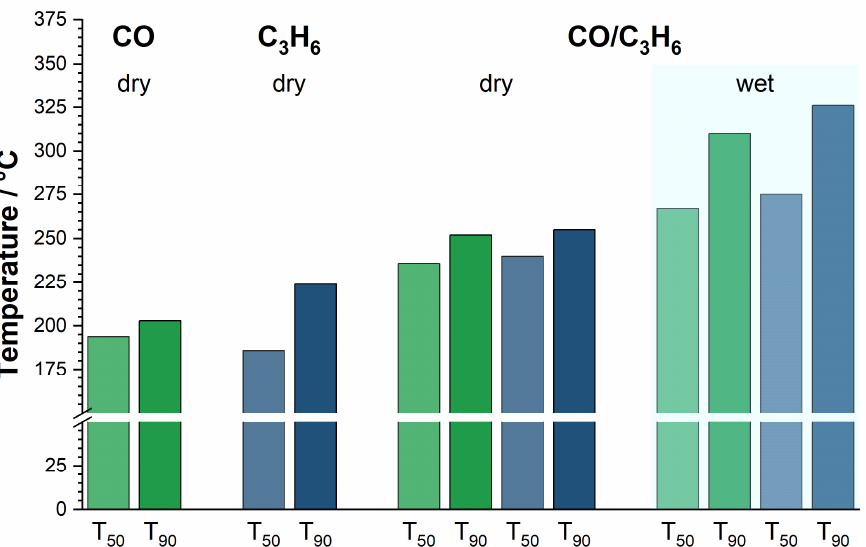
Figure 2. Temperatures of 50% (lighter shades) and 90% (darker shades) conversion for CO (green), C 3 H 6 (blue) and CO/C 3 H 6 oxidation reactions catalyzed by Pt single site.